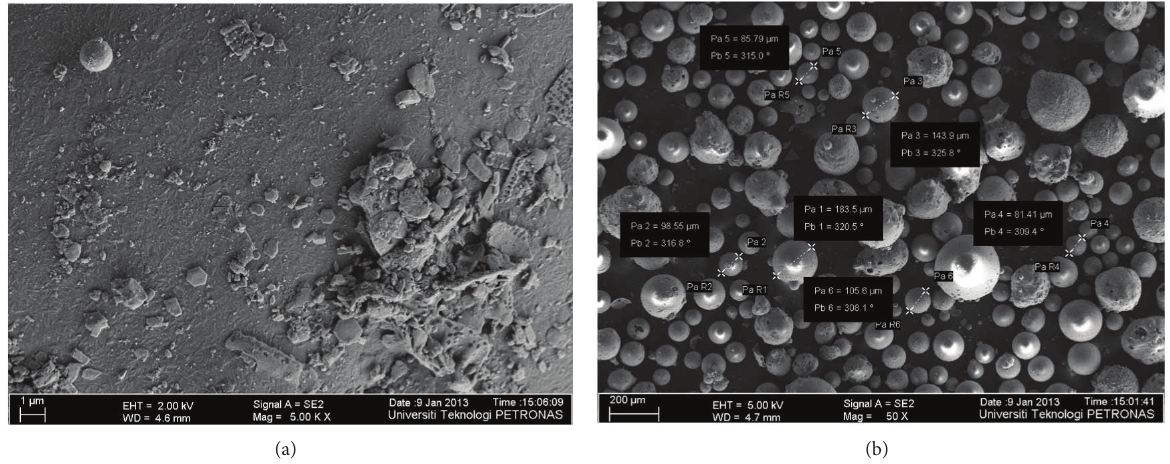
Figure 2: Microstructure of silica fume through field emission scanning electron microscope